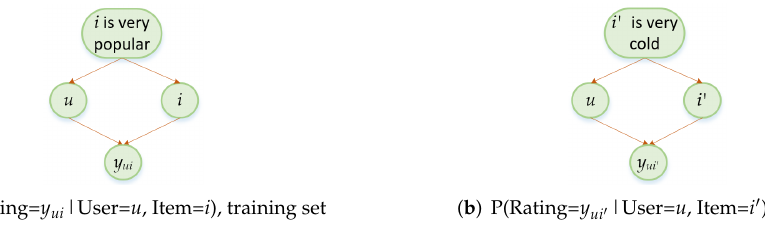
Figure 2. Two samples in a training set ( a ) and test set ( b ). Although the entities are the same or similar ( u = u , i ≈ i (cid:48) ), the popularity of the items is very different, which is not known by the traditional machine learning model.